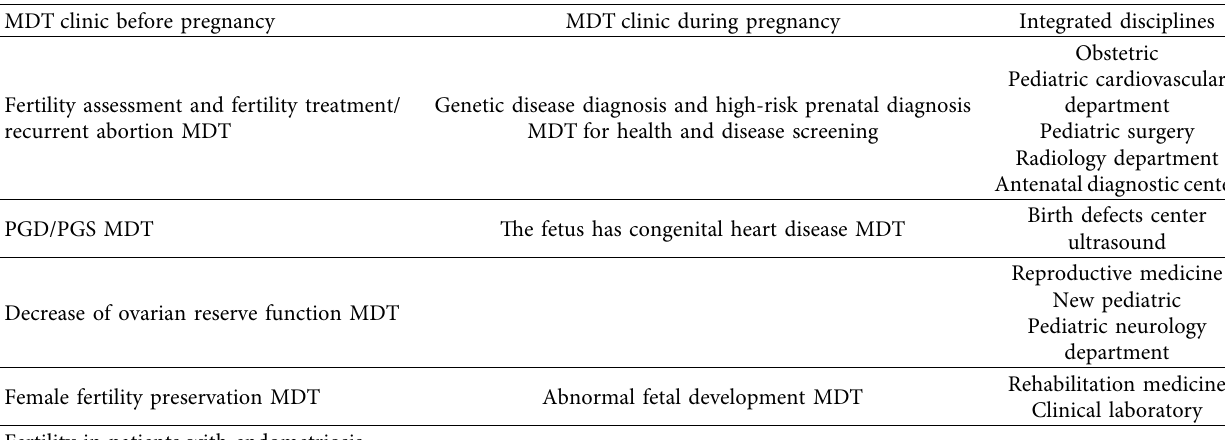
Table 2: MDT clinic based on the characteristics of fetal medicine platform.